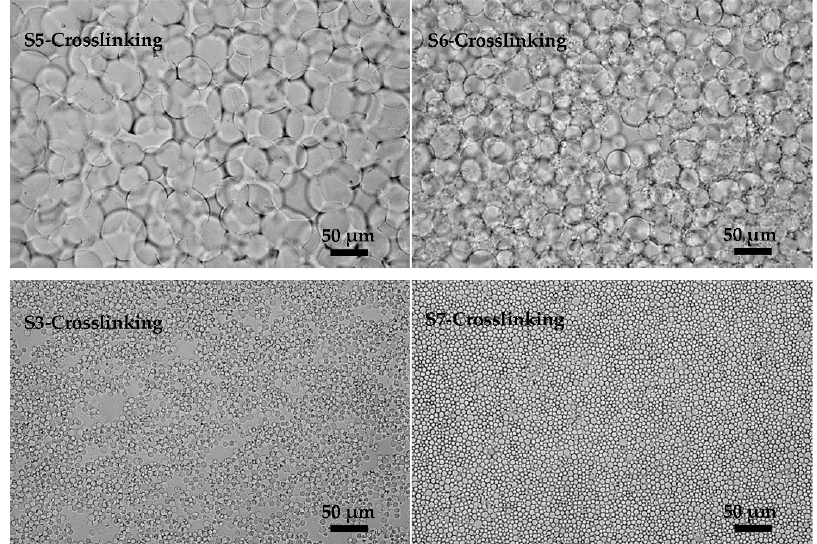
Figure 6. Microscopic photographs of KGM microspheres prepared with different KGM viscosities (KGM I, KGM II, KGM III and KGM IV): S5-Crosslinking, S6-Crosslinking, S3-Crosslinking and S7-Crosslinking were the crosslinking results of S5 , S6 , S3 and S7 .